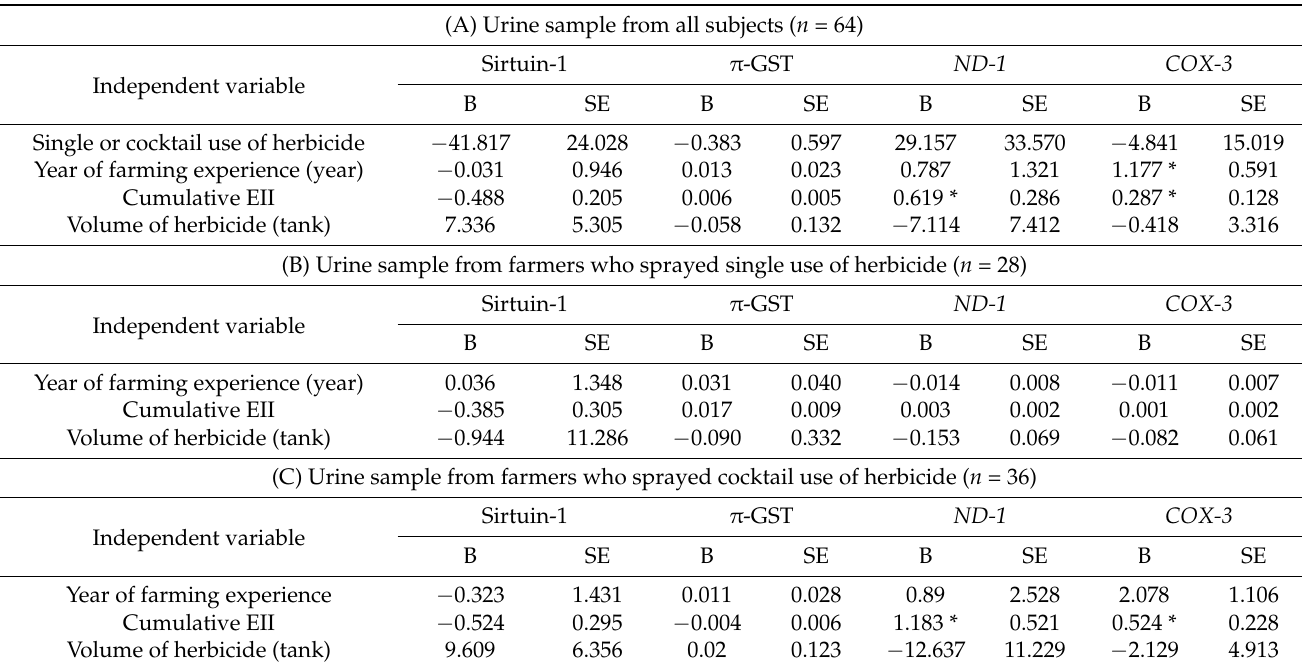
Table 4. The linear regression analysis in the association between influencing factors on change in urinary biomarker